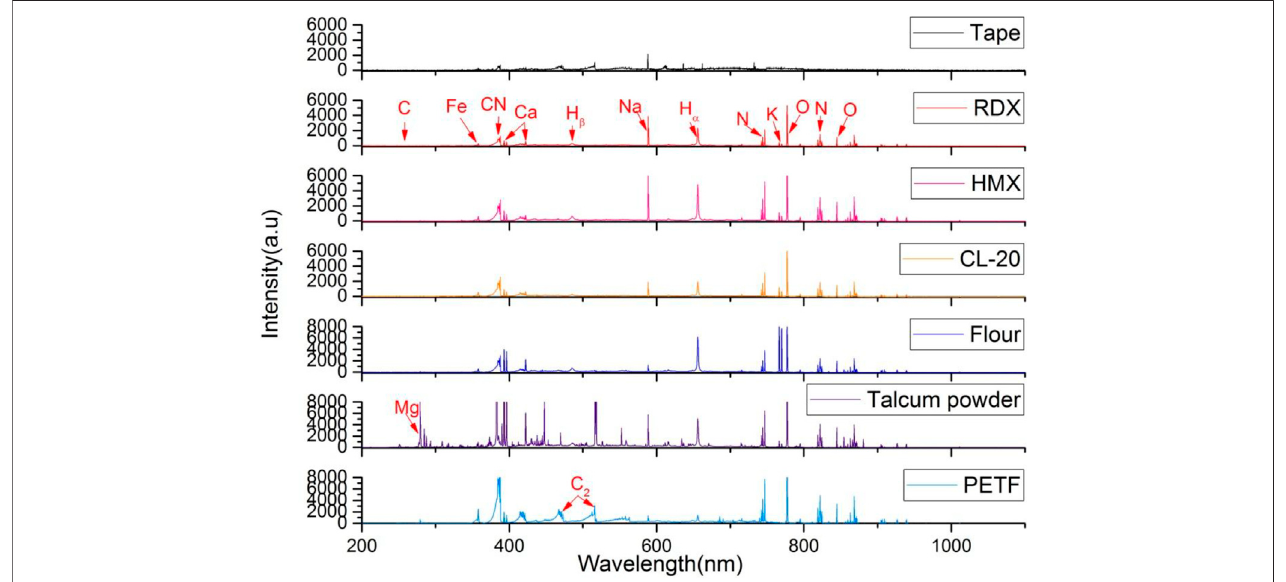
FIGURE 2 | Representation spectra of the six samples: CL-20, HMX, RDX, fl our, talcum powder, and PTFE.